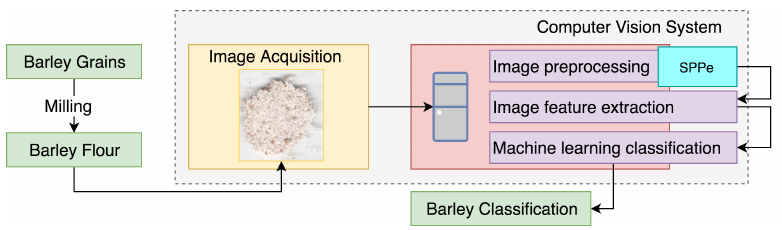
Figure 2. General overview of the proposed